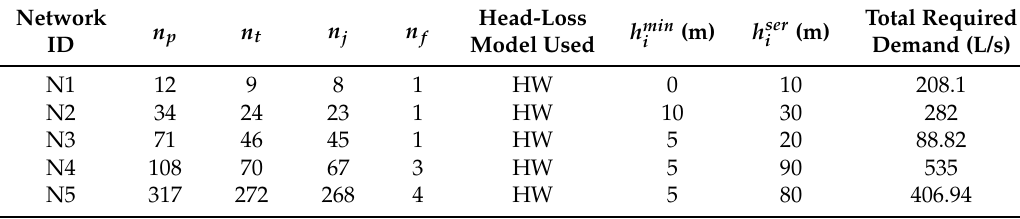
Figure 8. Comparison of the solution time for the case study networks: ( a ) CPU time for the DDM case; ( b ) CPU time for the PDM case. Table 1. Characteristics of the case study networks used for the performance